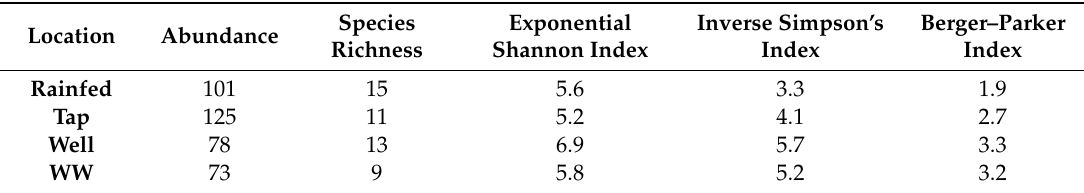
Table 2. Total abundance, total species richness, and diversity indices based on Hill numbers of tree communities found in four UPA locations under di ff erent irrigation sources, namely, rainfed (RF), tap water (Tap), well water (Well), and wastewater (WW) in Tamale, Ghana, in August 2016. Note that tree species abundance and richness were only sampled once per location; hence, no standard deviations were calculated. Species Exponential Inverse Simpson’s Location Abundance Richness Shannon Index